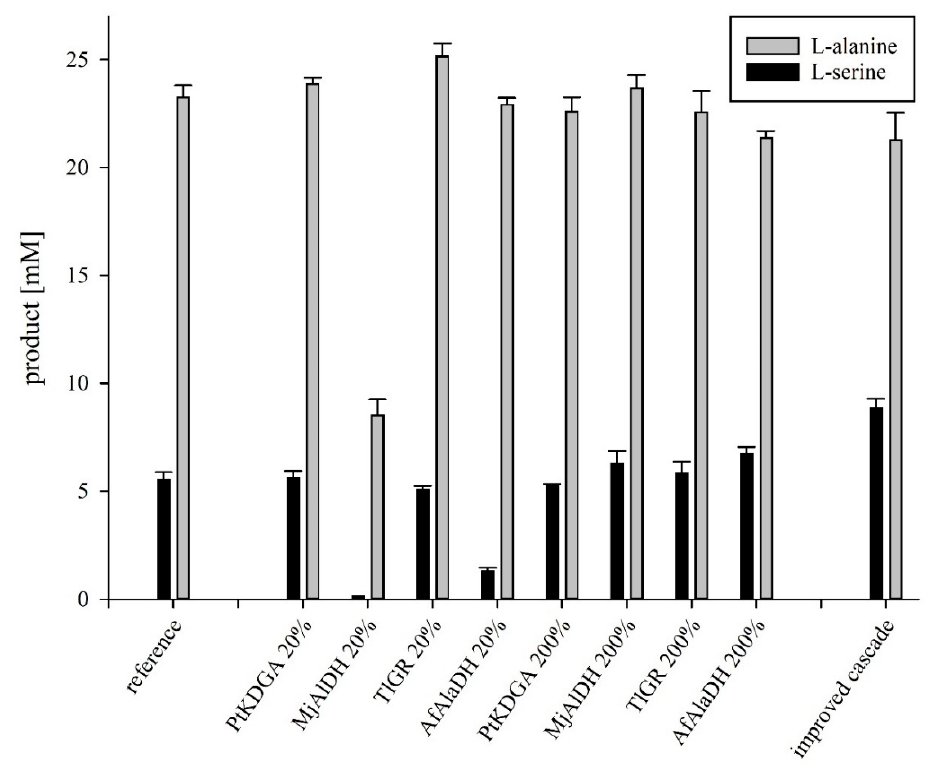
Figure 2. Overview of differently composed cascade variants as well as the resulting, improved cascade. Reaction mixtures contained enzymes, 150 mM ammonium sulfate, 5 mM NAD + , 25 mM KDG and 100 mM KP i buffer pH 8.0 at 50 ◦ C for 21 h. 0.5 U of each enzyme was used as a reference, based on the activity of the respective enzymes in the buffer KP i pH 8.0. As an approximation, the TIGR was quantified using the reverse reaction. Percentages relate to the enzyme specified in each case, based on the value of the reference. For the improved cascade, PtKDGA stayed at the value of the reference while the enzymes AfAlaDH, TlGR and MjAlDH were increased to 200%.